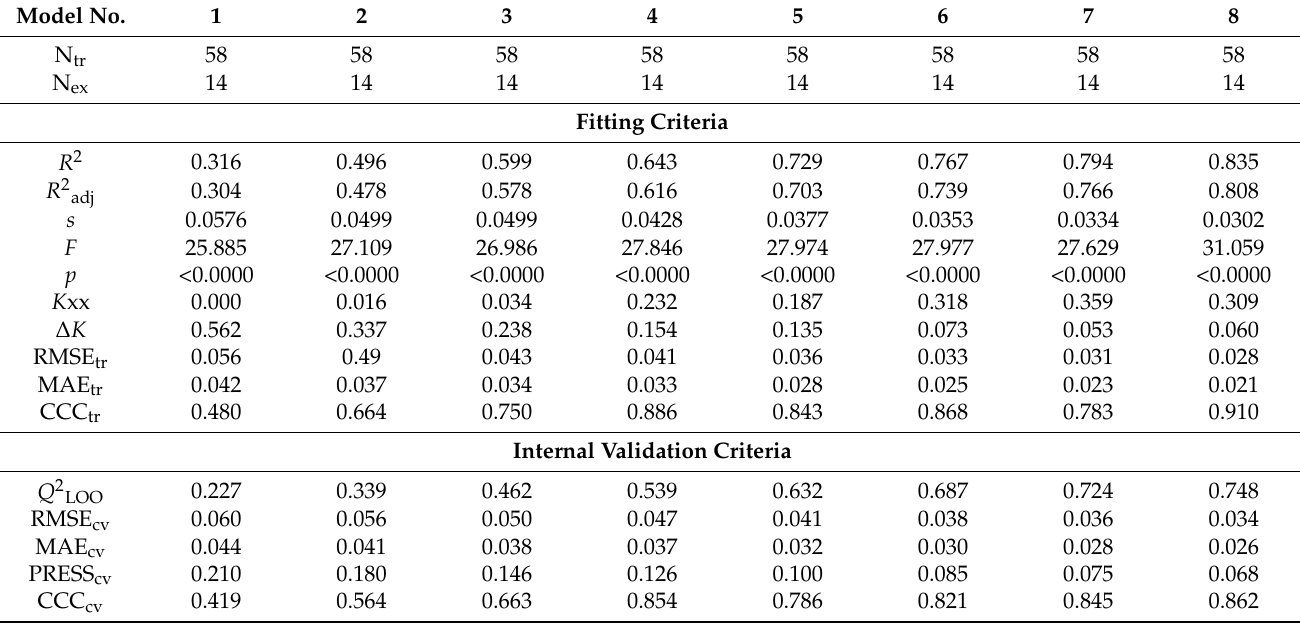
Table 3. Statistical parameters of obtained one- to eight-variable